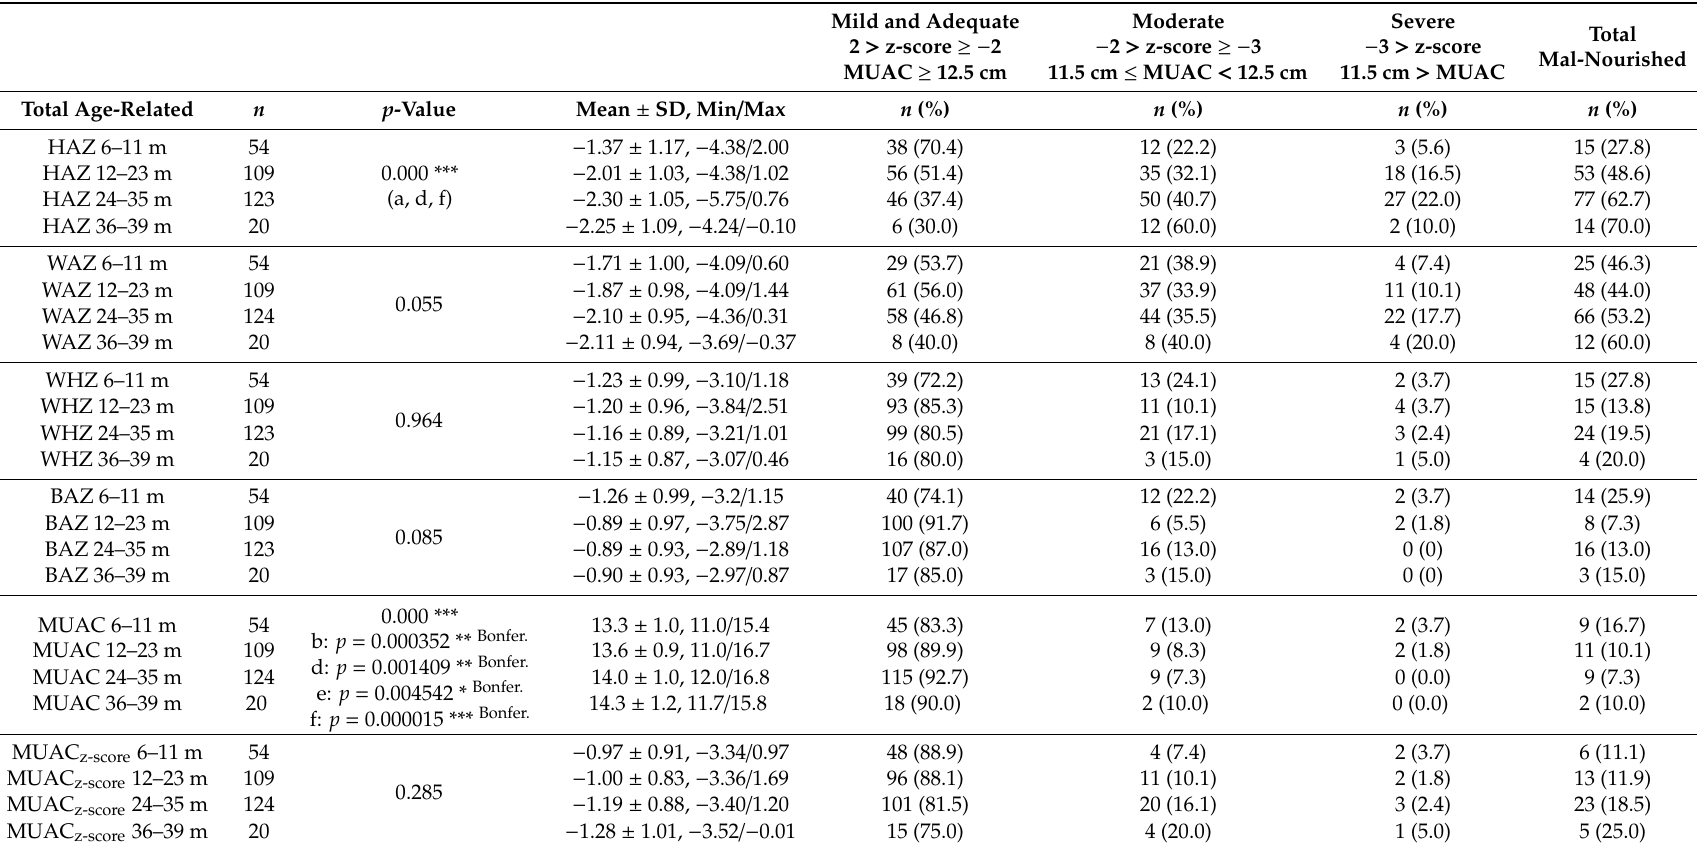
Table 2. Nutritional status by